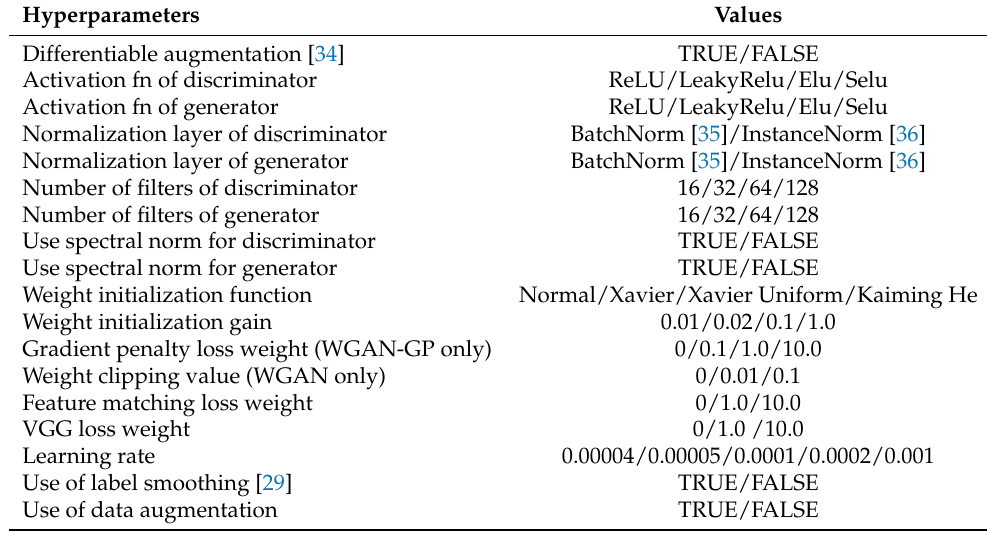
Table 1. List of the different hyperparameters optimized over.